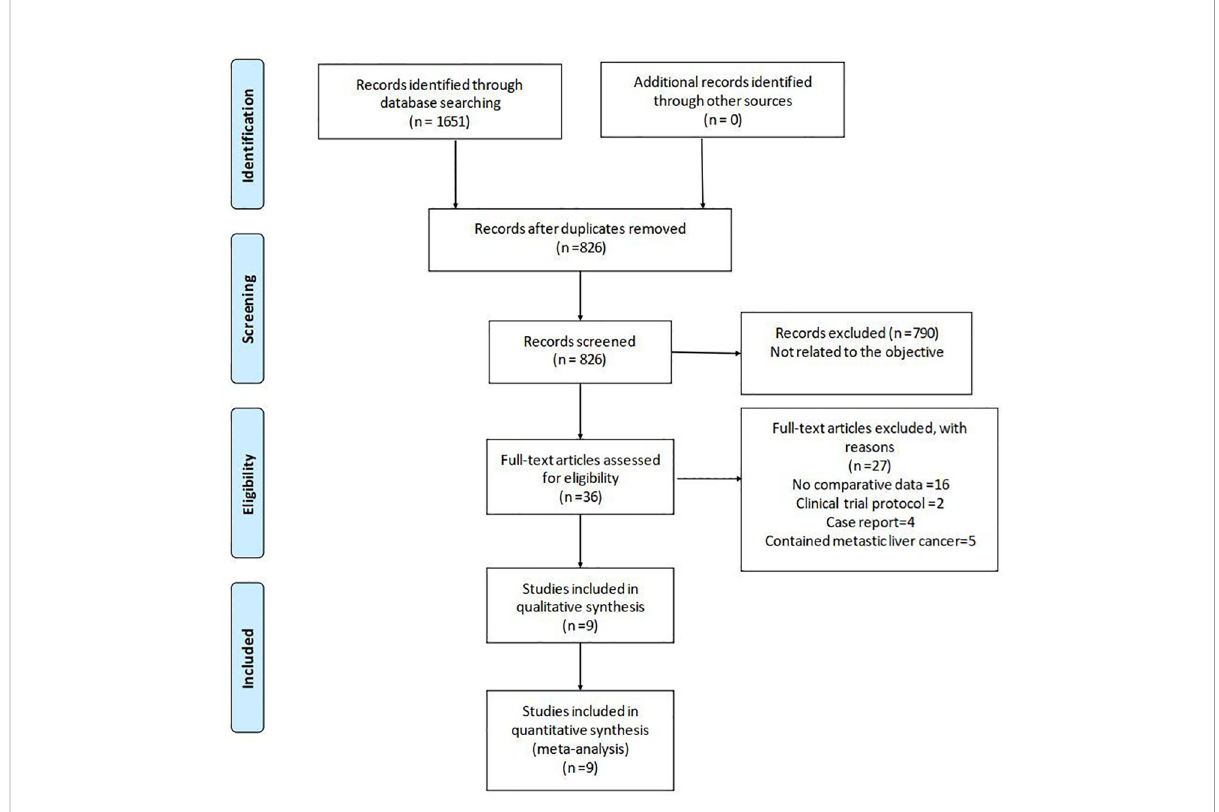
FIGURE 1 Flowchart of study identi fi cation and